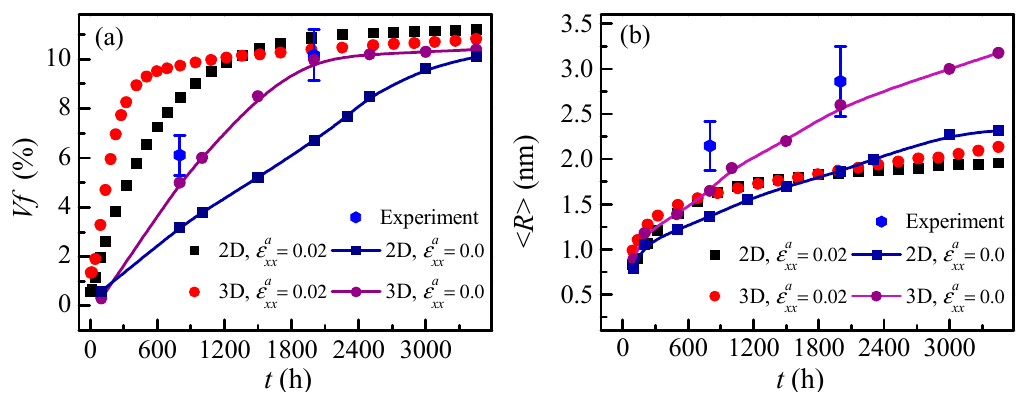
Figure 2. The evolution of the volume fraction Vf ( a ) and the average particle radius < R > ( b ) of α′ phase in Fe-25 at. % Cr alloy aged at 750 K under the applied uniaxial tensile strain 0.02 and 0.0 for 2D and 3D simulations, and the experimental data without applied strain.